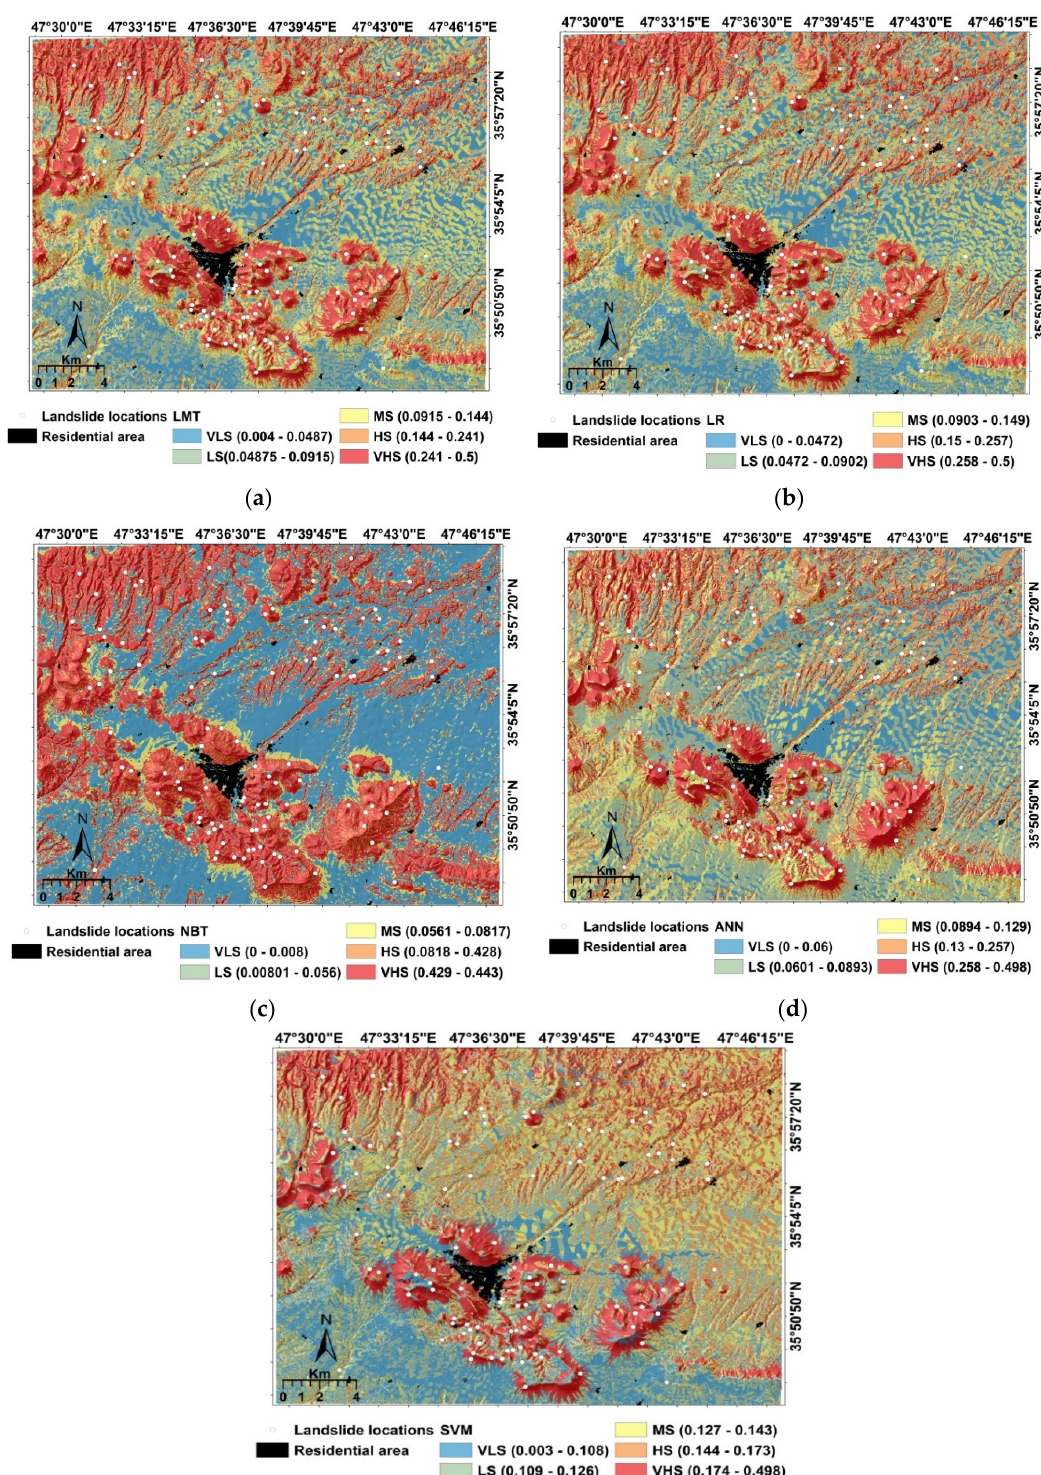
Figure 7. Landslide susceptibility maps: ( a ) Logistic Model Tree (LMT), ( b ) Logistic Regression (LR), ( c ) Naïve Bayes Tree ( NBT), ( d ) ANN, and ( e ) SVM.